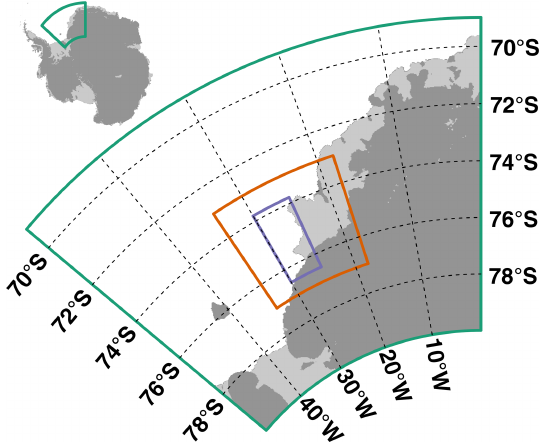
Figure 1. Location of the general (orange) and focus (purple) study area of the Antarctic Brunt Ice Shelf in the southeastern Wed- dell Sea (green). Data of land ice (dark gray) and floating ice shelves (light gray) are retrieved from RTopo-2 (Refined Topogra- phy; Schaffer et al.,